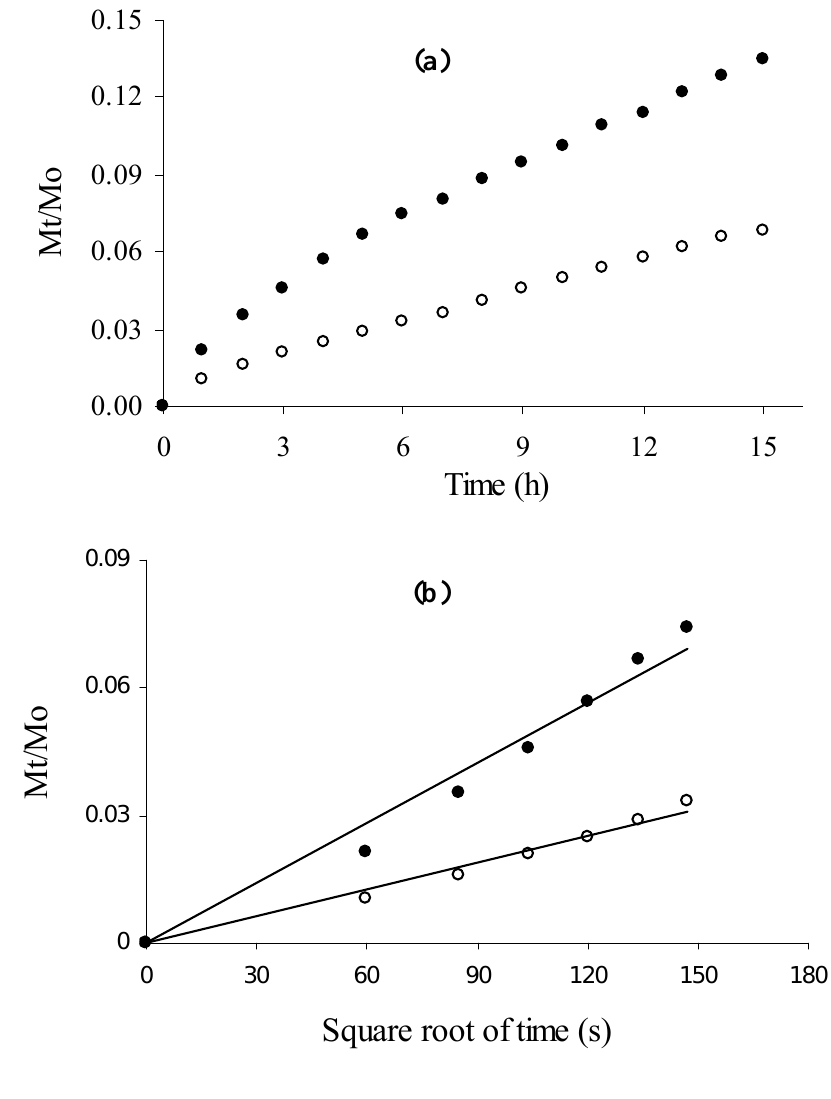
Figure 3. Cumulative release (Mt/Mo) of insulin (  ) and β -lactoglobulin (  ) from MBAX gels (a) as a function of time and (b) as a function of root time. Protein release was followed at 25°C and 90 rpm during 15 h. Gels at 2.5% (w/v) in MBAX and 0.1% (w/v)